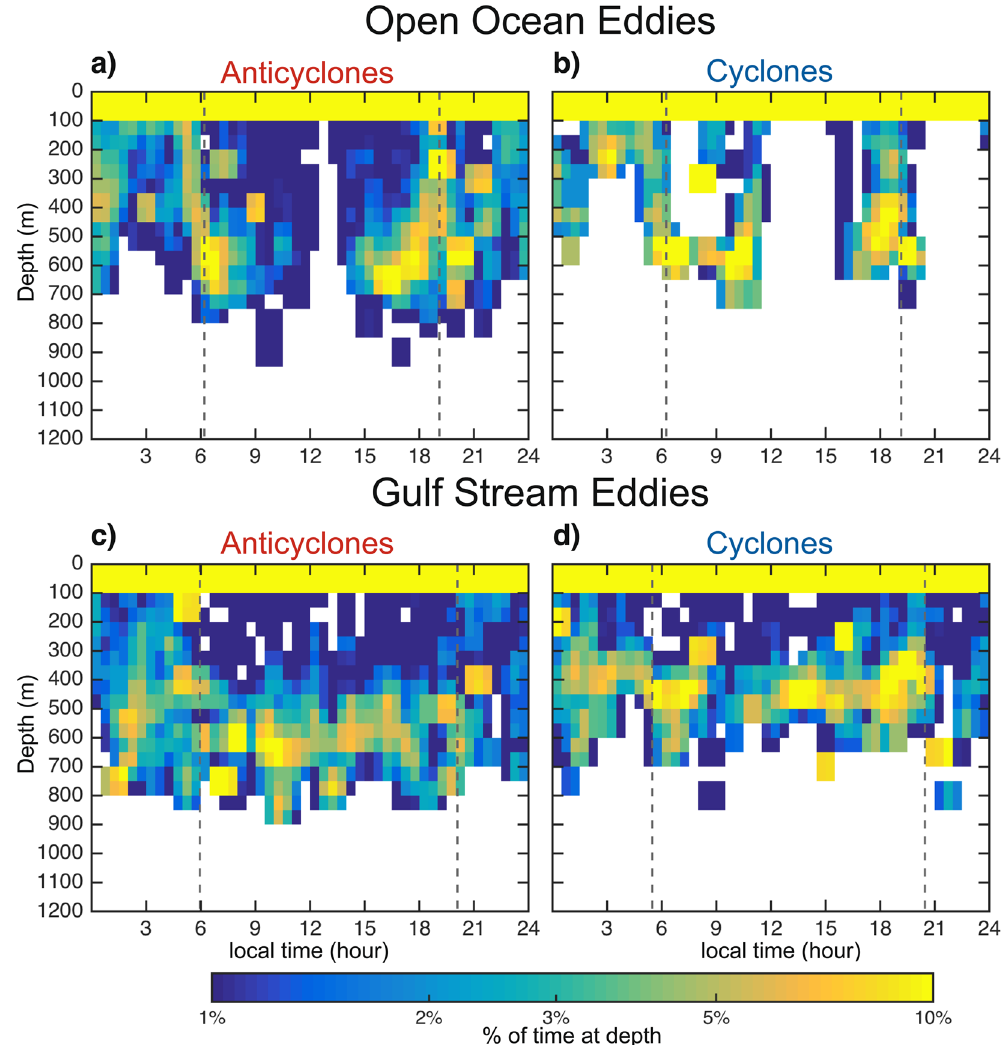
Figure 2. Two-dimensional histograms of dive depth as a function of local time. Dives within anticyclonic and cyclonic mesoscale eddies are shown in the left and right columns, respectively, on a log scale. Thin vertical broken grey lines represent the mean time of local sunrise and sunset. Dives occurring while the shark interacted with eddies in the open ocean region are shown in the top row and with eddies in the Gulf Stream region are shown in the bottom row. White indicates no